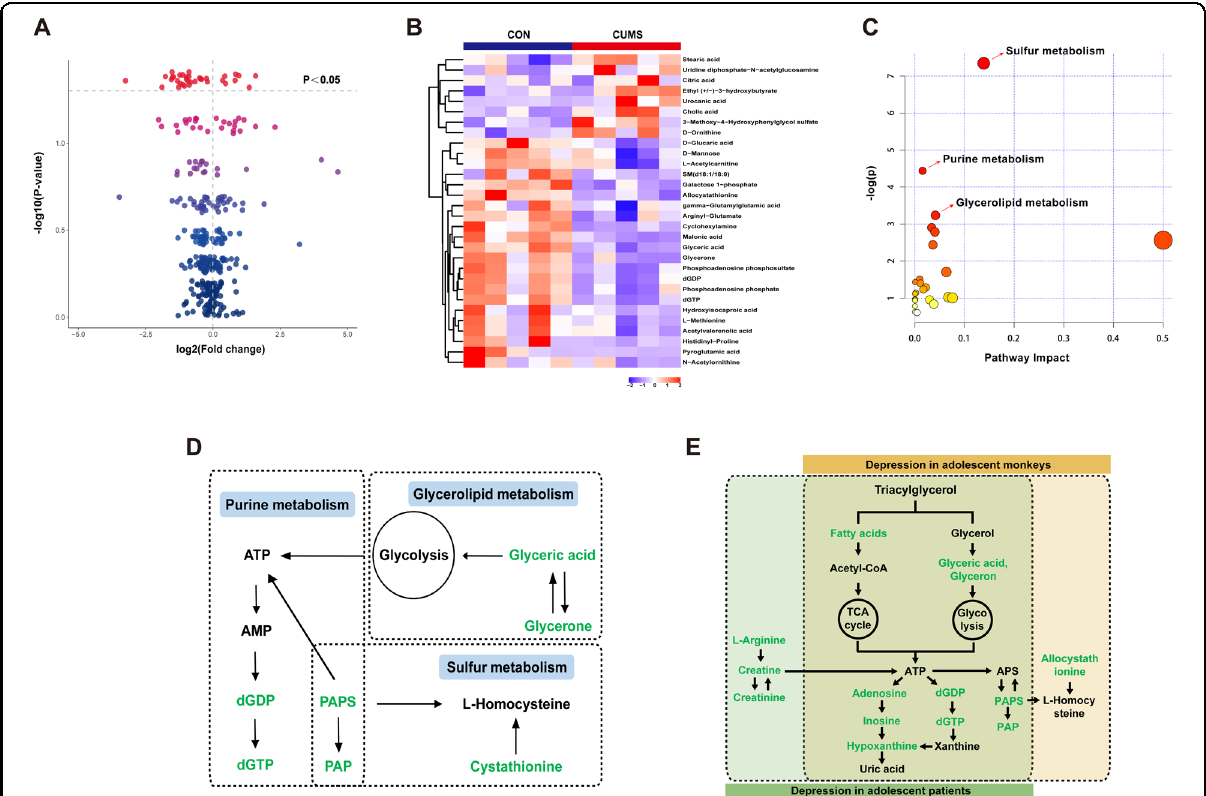
Fig. 5 Plasma metabolomics analysis in CUMS and CON groups. A The volcano plot for the differential metabolites in CUMS and CON groups; red nodes = P < 0.05. B The heat plot for the differential metabolites in CUMS and CON groups. C The pathway analysis of differential metabolites of CUMS and CON groups in MetaboAnalyst; red nodes = P < 0.05. D A simpli fi ed interaction diagram of the altered pathways in CUMS and CON groups. Metabolites in green decreased. E A simpli fi ed interaction diagram of altered pathways between adolescent depression monkeys and patients. Metabolites in green